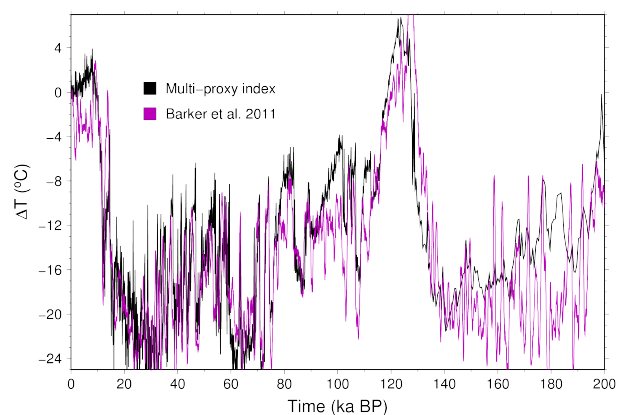
Fig. 3. Black: Multi-proxy index used in this study, expressed as an annual mean temperature anomaly Fig. 3. Black: multi-proxy index used in this study, expressed as an relative to present day. Purple: Barker et al. (2011) synthetic Greenland δ 18 O, converted into an annual annual mean temperature anomaly relative to present day. Purple: mean temperature anomaly with Eq. 2. The index used in this study exhibits a warming greater than Barker et al. (2011) synthetic Greenland δ 18 O, converted into an +5 ◦ C during the LIG. This value is much lower than Barker et al. (2011), which remains over +8 ◦ C during 2 ka. annual mean temperature anomaly with Eq. (2). The index used in this study exhibits a warming greater than +5 ◦ C during the LIG. This value is much lower than that of Barker et al. (2011), which remains over +8 ◦ C during